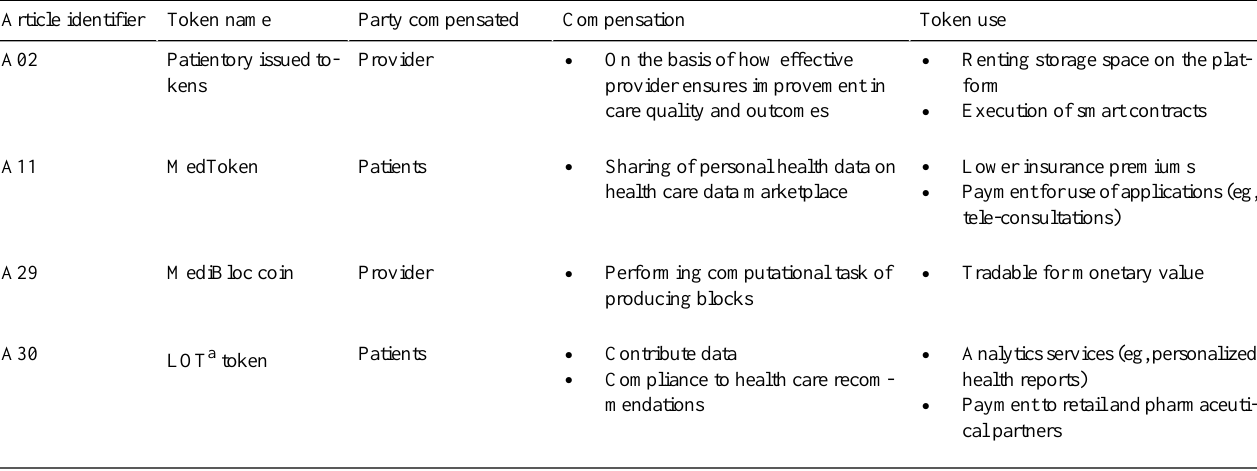
Table 4. Incentive structure proposed by blockchain personal health record systems.